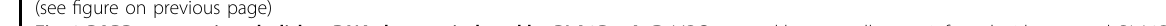
Fig. 3 PARP1 expression abolishes DNA damage induced by PLA2R1. A – D MRC5 normal human cells were infected with a control, PLA2R1-, or PARP1-encoding retroviral vectors as indicated and selected. A RNA was prepared and RTqPCR performed against PLA2R1 or PARP1 and normalized against GAPDH levels. The results shown are mean ± SEM of three independent experiments. P value was calculated using Student ’ s t -test. * p < 0.05; ** p < 0.01; *** p < 0.001. B , C Cells were fi xed in methanol and immuno fl uorescence staining against 53BP1 ( B ) and γ H2AX ( C ) was performed with indicated antibodies. Images were taken using a Nikon Fluorescence microscope and quanti fi ed with the Focinator software. More than 50 nuclei were analyzed per condition. The p value was calculated using the Mann – Whitney test. * p < 0.05; ** p < 0.01; *** p < 0.001. D Comet assay for assessing DNA breaks was performed. After migration, the slides were stained with SYBR Safe. Tail moments (1/4 tail length DNA in the tail/total DNA) were analyzed using the Casplab software. A least 50 nuclei were analyzed per condition. The p value was calculated using the Mann – Whitney test, *** p < 0.001.